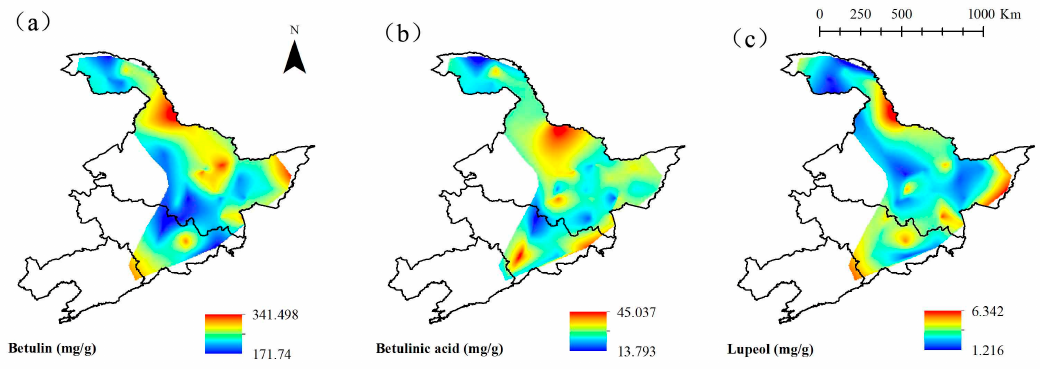
Figure 3. Spatial distributions of concentrations of three triterpenoids of betulin ( a ); betulinic acid ( b ) and lupeol ( c ) in barks of white birch trees from 48 sampling plots in Northeast China.